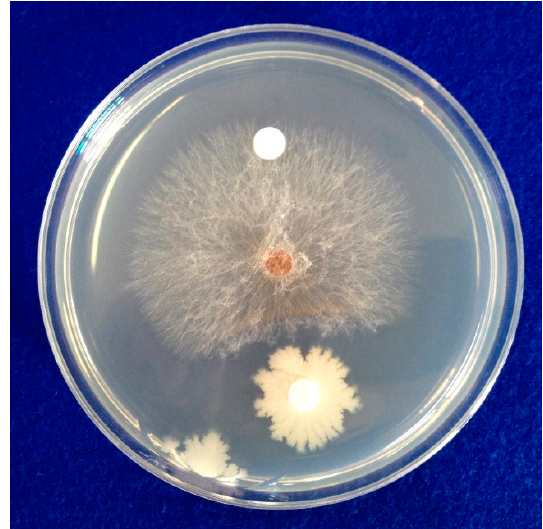
Figure 1. Antifungal activity of Bacillus subtilis SA-15 against Rhizoctonia solani AG 2-2 (IV) on PDA medium B. subtilis -incoulated paper disk (bottom) compared with control disk (top).